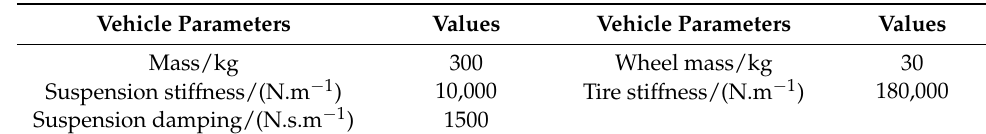
Table 2. Vehicle model parameters.